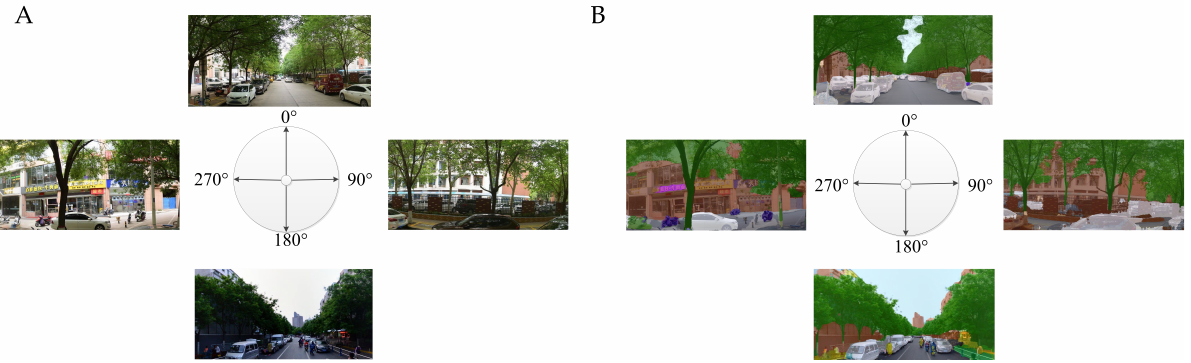
Figure 3. Segmentation results of FCN-8s Net (( A ) the original images; ( B ) segmentation images). Yang et al. [42] proposed the GVI to assess the visibility of urban forests. Street landscape greening at each sampling point was defined as the ratio of the number of